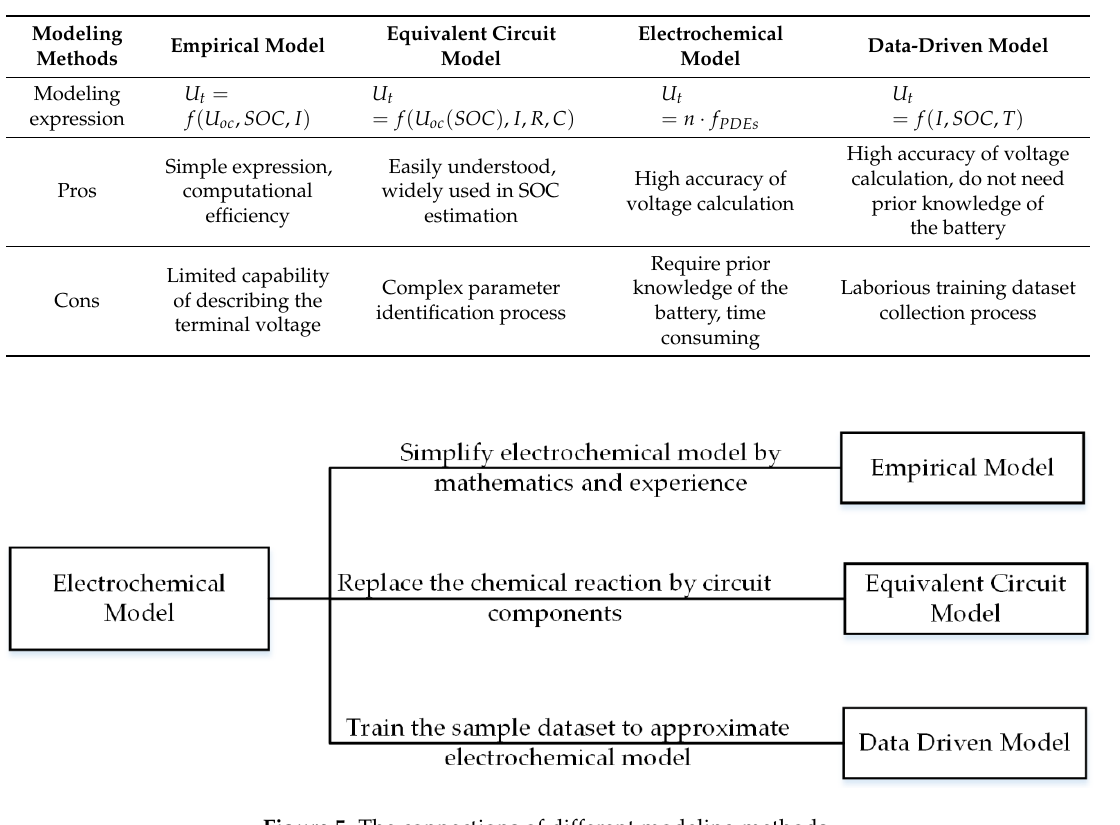
Figure 5. The connections of different modeling methods.